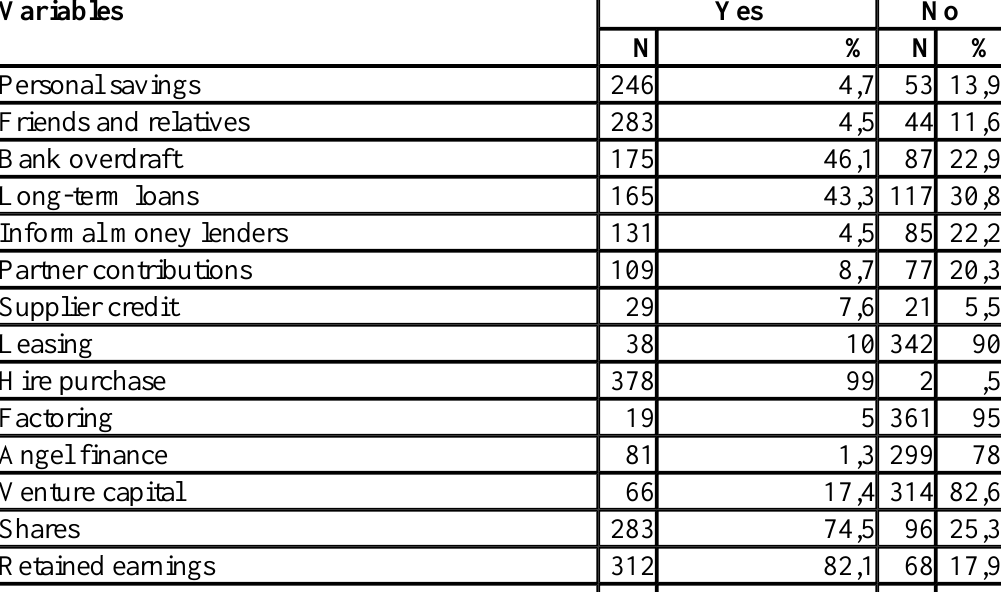
Table 2 Manufacturing SMEs awareness of alternative sources of